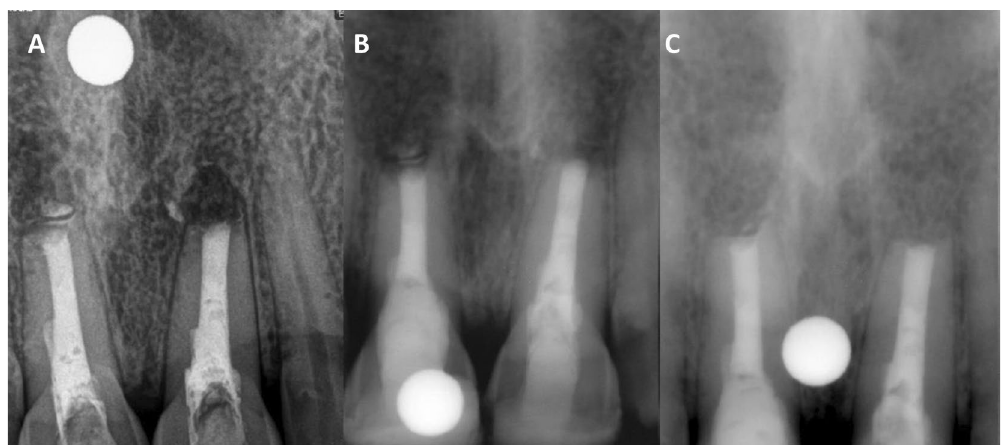
Figure 1. (A) Immediate postoperative periapical radiograph showing periapical radiolucency around the apex of Tooth 11 and 21. ( B ) Periapical radiolucency decreased in 6 months. ( C ) Complete resolution of periapical radiolucency in 1